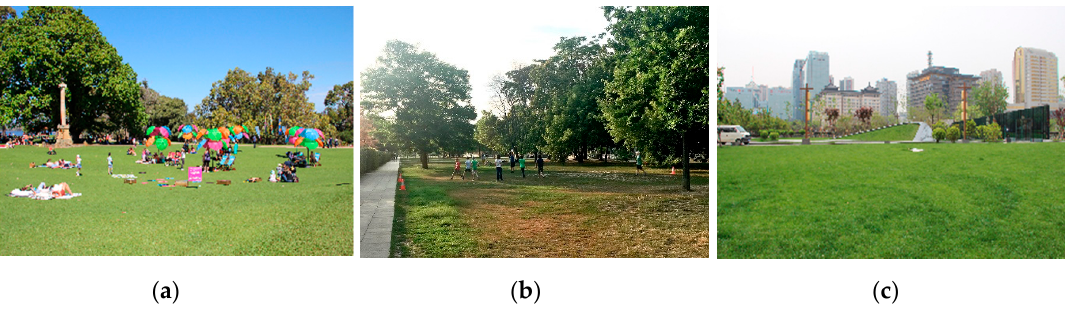
Figure 3. Lawn as a special leisure space in urban parks worldwide: a ) King’s Park in Perth, Australia; b ) Lene-Voigt Park in Leipzig, Germany; c ) one of the public parks in Xian, China. Photos: M. Ignatieva, D. Dushkova.